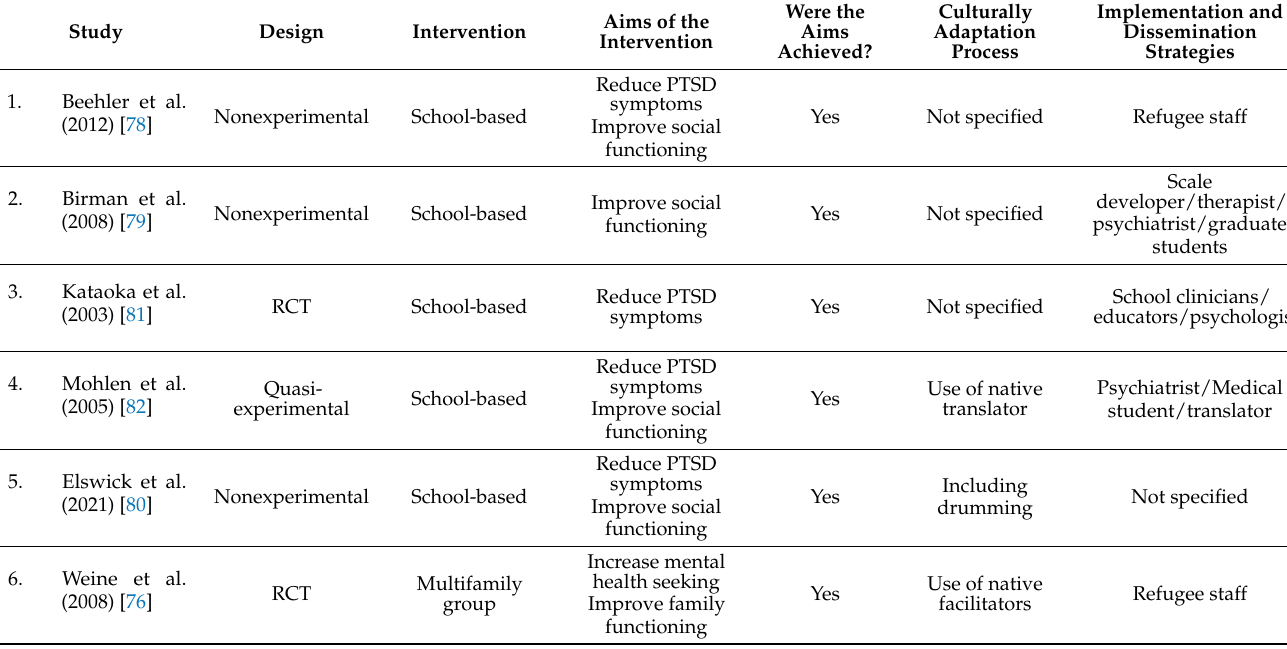
Table A1. Description of studies included in the